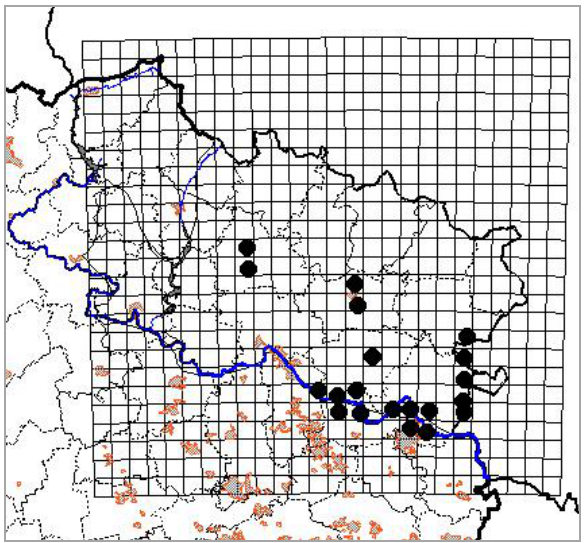
Fig. 7. The map of the distribution of Amorpha fruticosa L. in the Starobilsk grass-meadow steppe